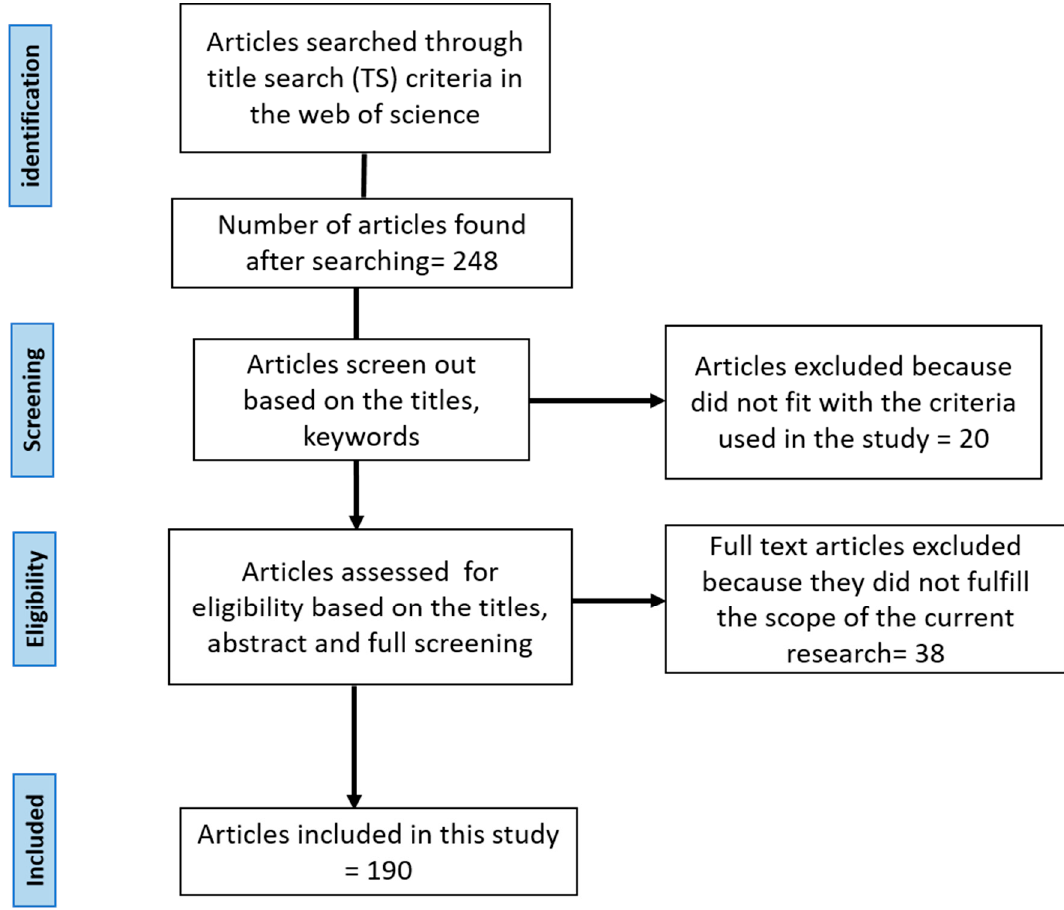
Figure 3. The flowchart diagram for screening articles for this study.